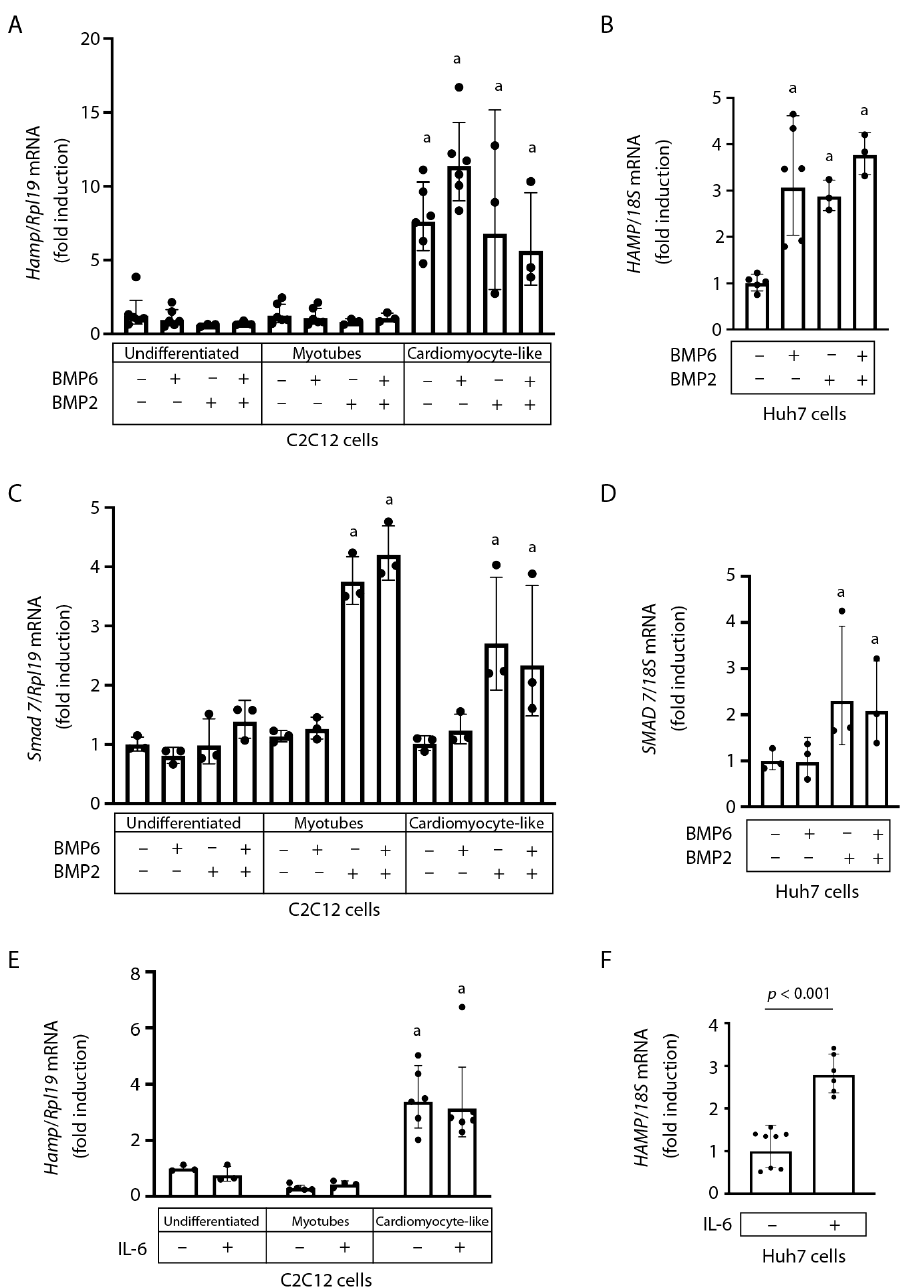
Figure 2. Expression of Hamp mRNA in C2C12 cardiomyocyte-like cells does not respond to major inducers of hepatic hepcidin. C2C12 cells, grown as described in Figure 1, and Huh7 hepatoma cells were treated for 4 h with 5 ng/mL BMP6 and/or BMP2, 20 ng/mL murine IL-6 (C2C12 cells), or 10 ng/mL human IL-6 (Huh7 cells). Gene expression was analyzed by qPCR. ( A – D ) Hamp ( A ), HAMP ( B ), Smad7 ( C ), and SMAD7 ( D ) mRNA levels following BMP6 and/or BMP2 treatments. ( E , F ) Hamp ( E ) and HAMP ( F ) mRNA levels following treatments with murine or human IL-6, respectively. Gene expression data are represented as geometric mean ± geometric standard deviation. Statistically significant differences ( p < 0.05) versus undifferentiated C2C12 or untreated Huh7 cells are indicated by a .